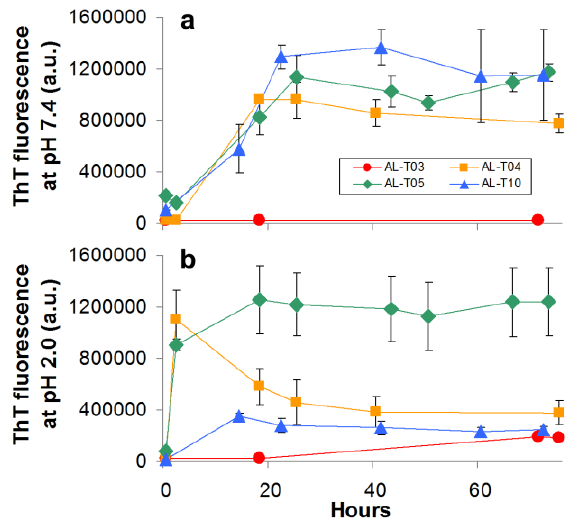
Figure 4. AL proteins show differences in their ability to form amyloid fibrils in vitro . Increase in ThT fluorescence over time indicates amyloid fibril formation. At pH 2.0, the proteins form amyloid fibrils faster than at pH 7.4. AL-T03 was only capable of forming amyloid fibrils at pH 2.0.